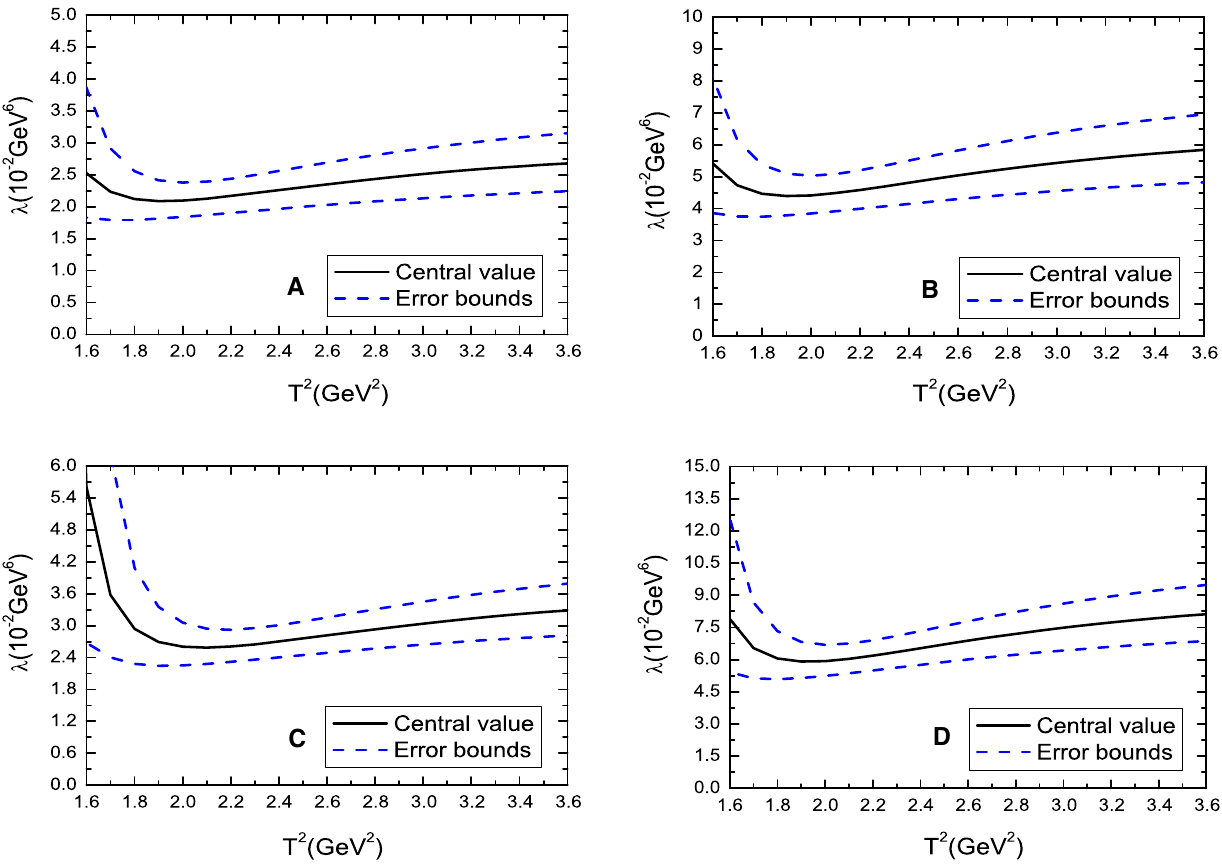
Fig. 2 ThepoleresiduesofthevectortetraquarkstateswithvariationsoftheBorelparameters T 2 ,wherethe A , B , C and D denotethe | 0 , 0 ; 0 , 1 ; 1 (cid:8) , | 1 , 1 ; 0 , 1 ; 1 (cid:8) , 1 √ ( | 1 , 0 ; 1 , 1 ; 1 (cid:8) + | 0 , 1 ; 1 , 1 ; 1 (cid:8) ) and | 1 , 1 ; 2 , 1 ; 1 (cid:8) vector tetraquark states, respectively 2 Table 5 The masses of the vector tetraquark states